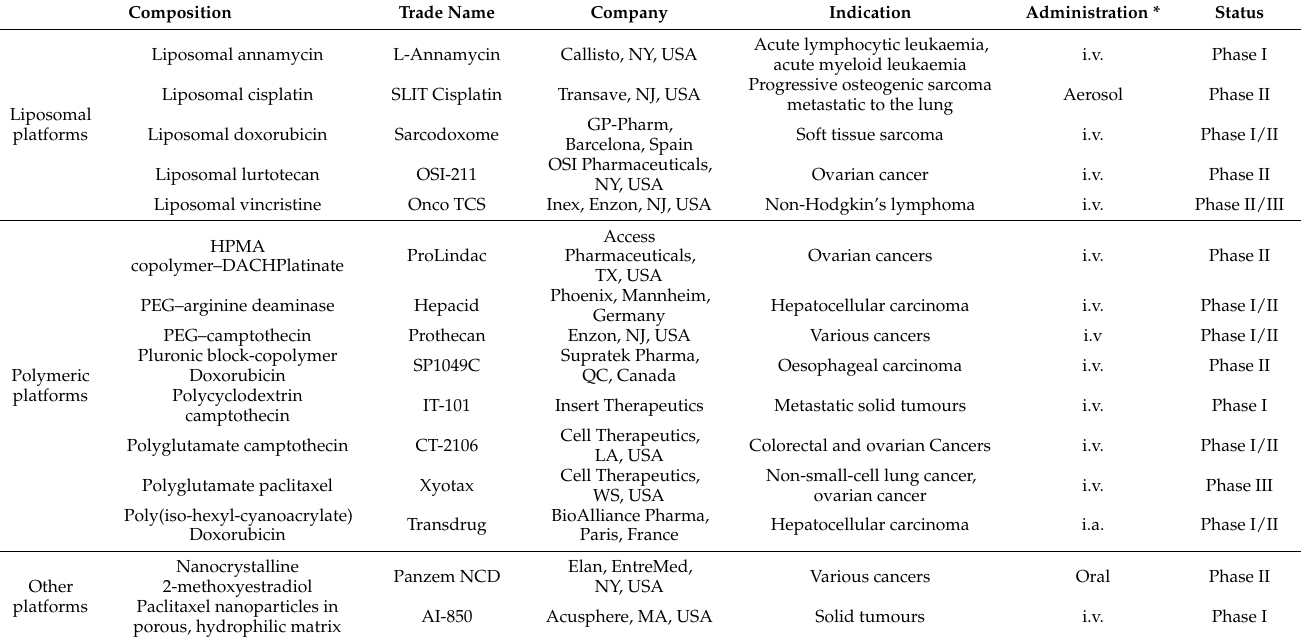
Table 4. Nanoparticle-based cancer therapeutics in clinical